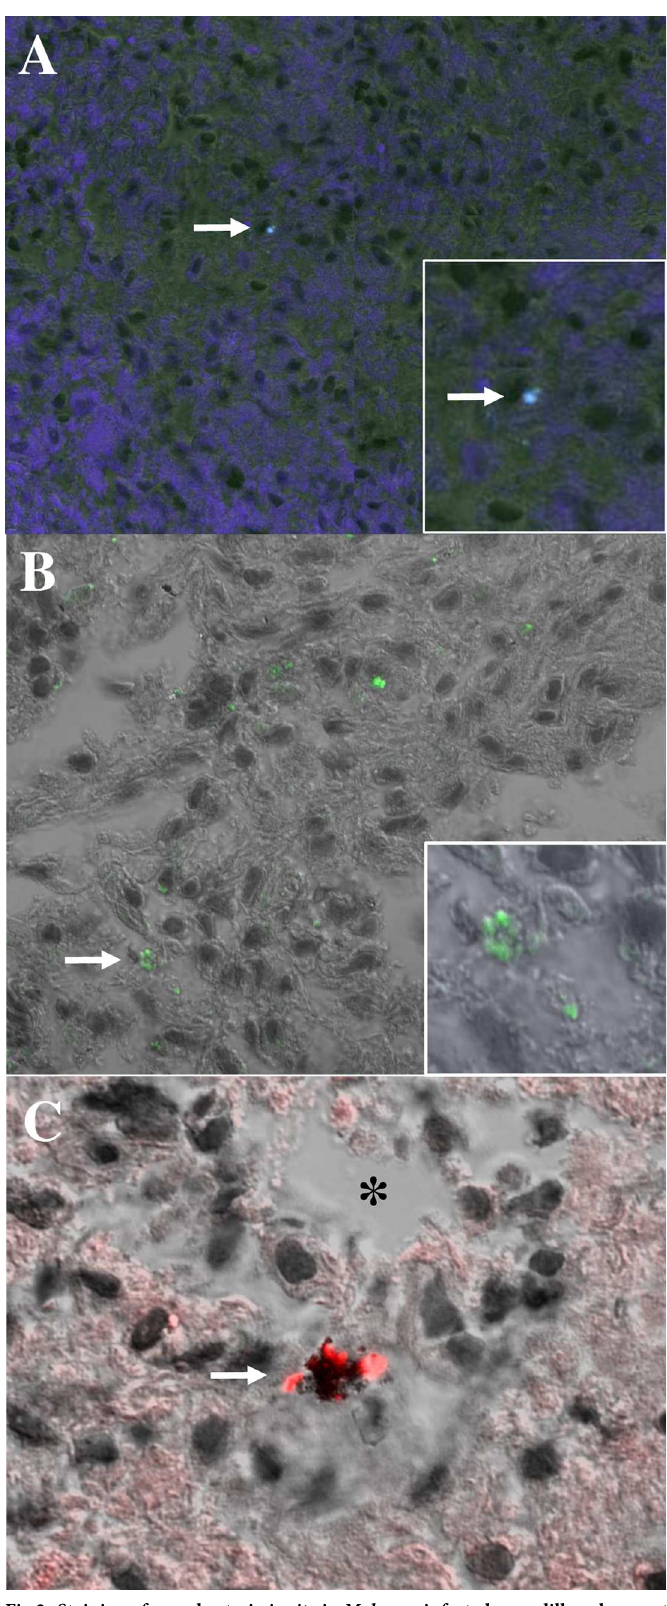
Fig 2. Staining of mycobacteria in situ in M . leprae infected armadillo spleen sections. A) SYBR Gold staining (blue) of M . leprae in armadillo spleen A7, arrow denotes stained bacillus. Insert, enlarged area showing